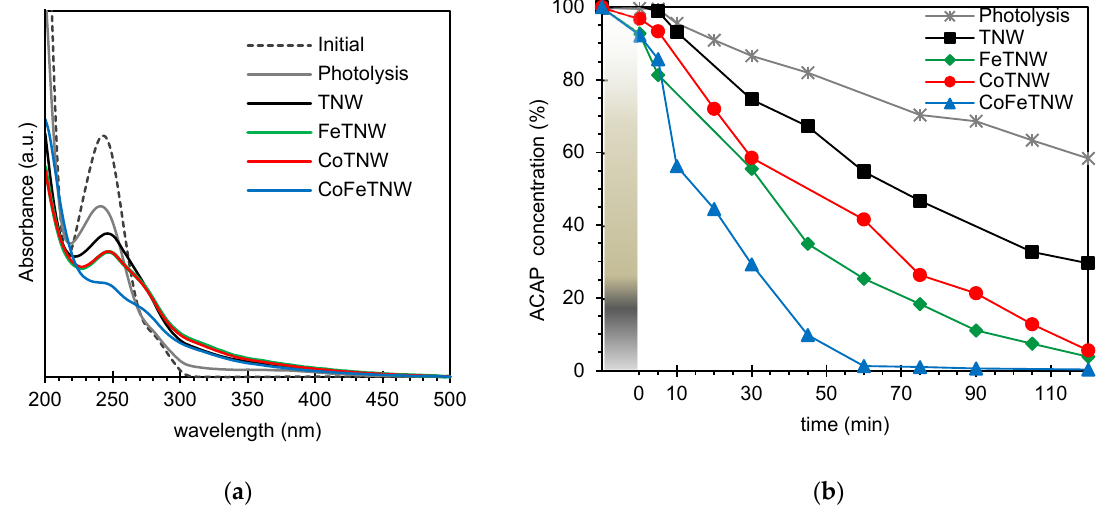
Figure 5. UV-vis spectra ( a ) of a 20 ppm ACAP solution after 120 min of irradiation, and ( b ) degradation profiles obtained from LC-ESI-QTOF-MS, using the prepared samples as photocatalysts (20 mg of catalyst to 150 mL of ACAP solution).